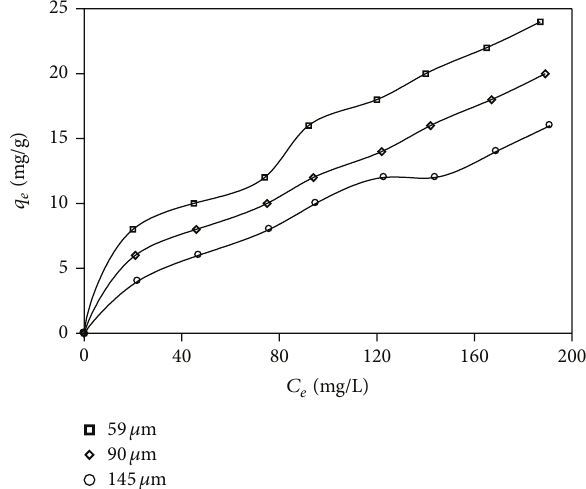
Figure7:Effectofparticlesizeontheadsorptionof3,5-xylenolonto